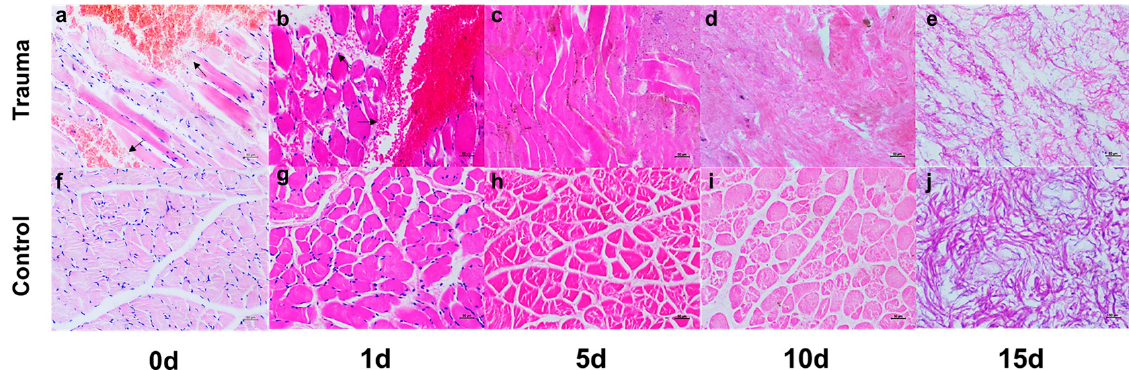
Figure 1. Microscopic visualization of HE staining in trauma group and control group at different time points. ( a – e ) The observation of the wound group under the HE staining microscope. The rose red color shows the cytoplasm and intercellular stroma, blue shows the nucleus, and the black arrow indicates the bleeding area and red blood cells. ( f – j ) The observation of the control group under the microscope of HE staining. Rose red is the cytoplasm and intercellular stroma, and blue is the